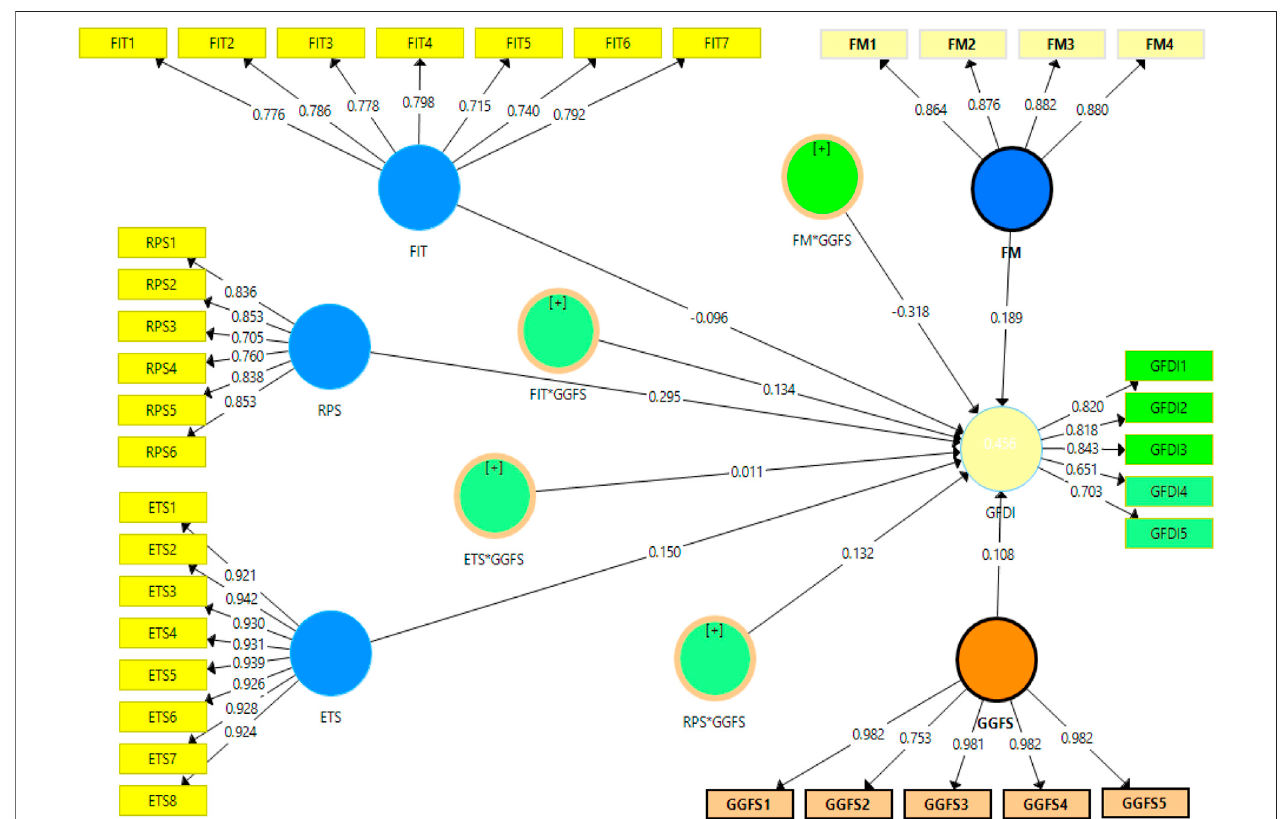
FIGURE 2 | Measurement assessment